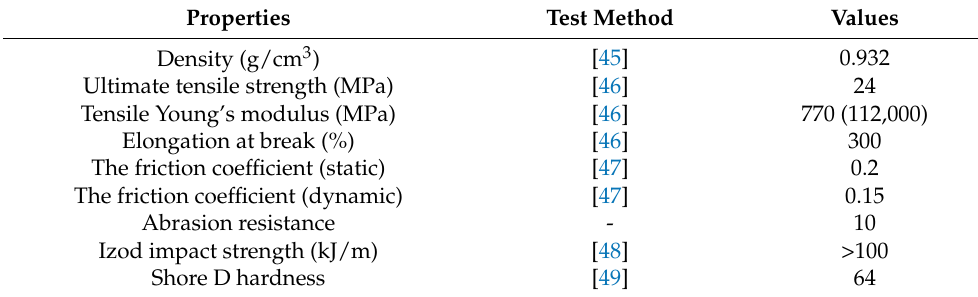
Table 11. The properties of the materials fabricated by ‘Polymer Industries’